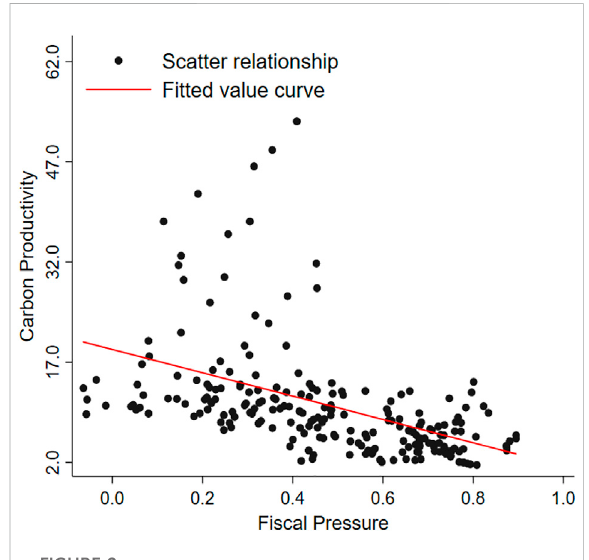
FIGURE 2 Scattered relationship between fi scal pressure and carbon